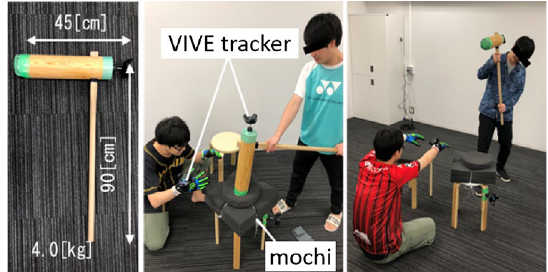
Fig. 1 Real environment system overview